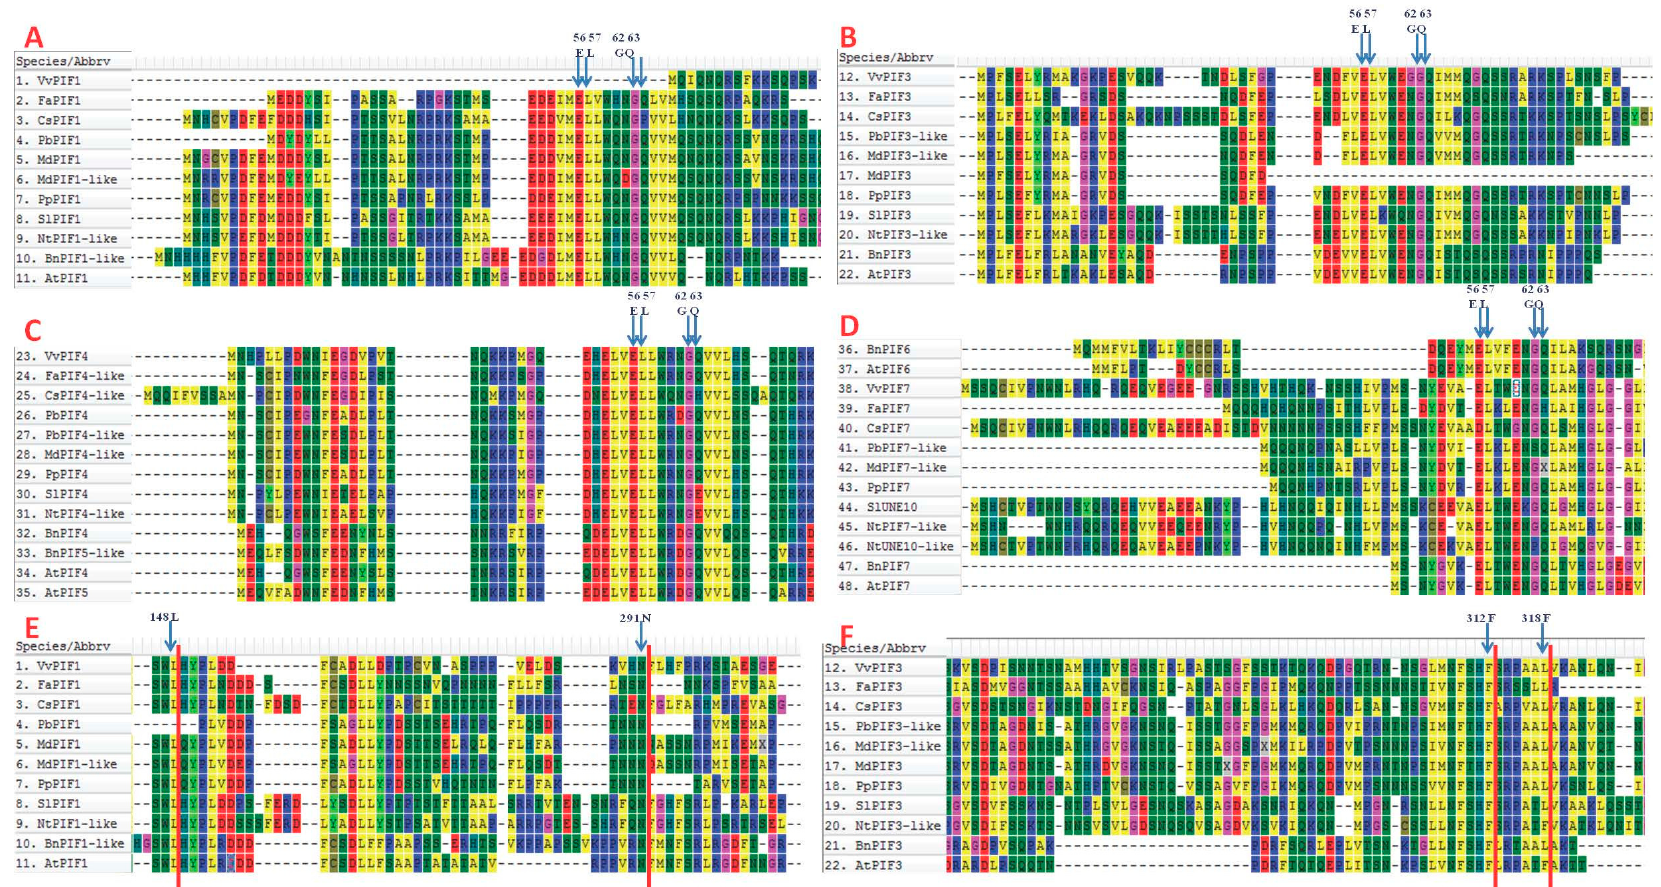
Figure 3. The multiple alignment of deduced amino acid sequences of PIFs for the comparison of active PHYB binding (APB) and active PHYA binding (APA) conserved domains. ( A – D ) Comparison of APB conserved domains in PIFs; ( E ) Comparison of APA conserved domains in PIF1; ( F ) Comparison of APA conserved domains in PIF3. The amino acid of the conserved site has been marked above the corresponding column.